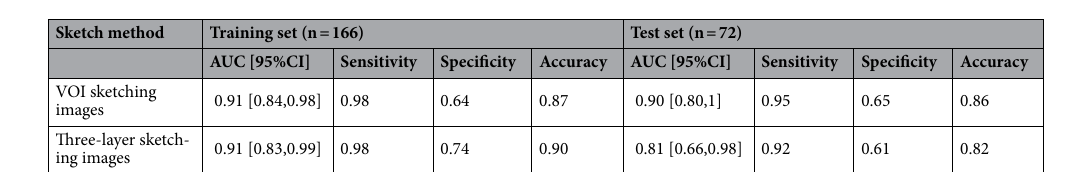
Table 5. AUC, sensitivity, specificity, and overall accuracy of SVM prediction models for the training and test sets for the two sketching methods. AUC=area under the receiver operating characteristic curve.